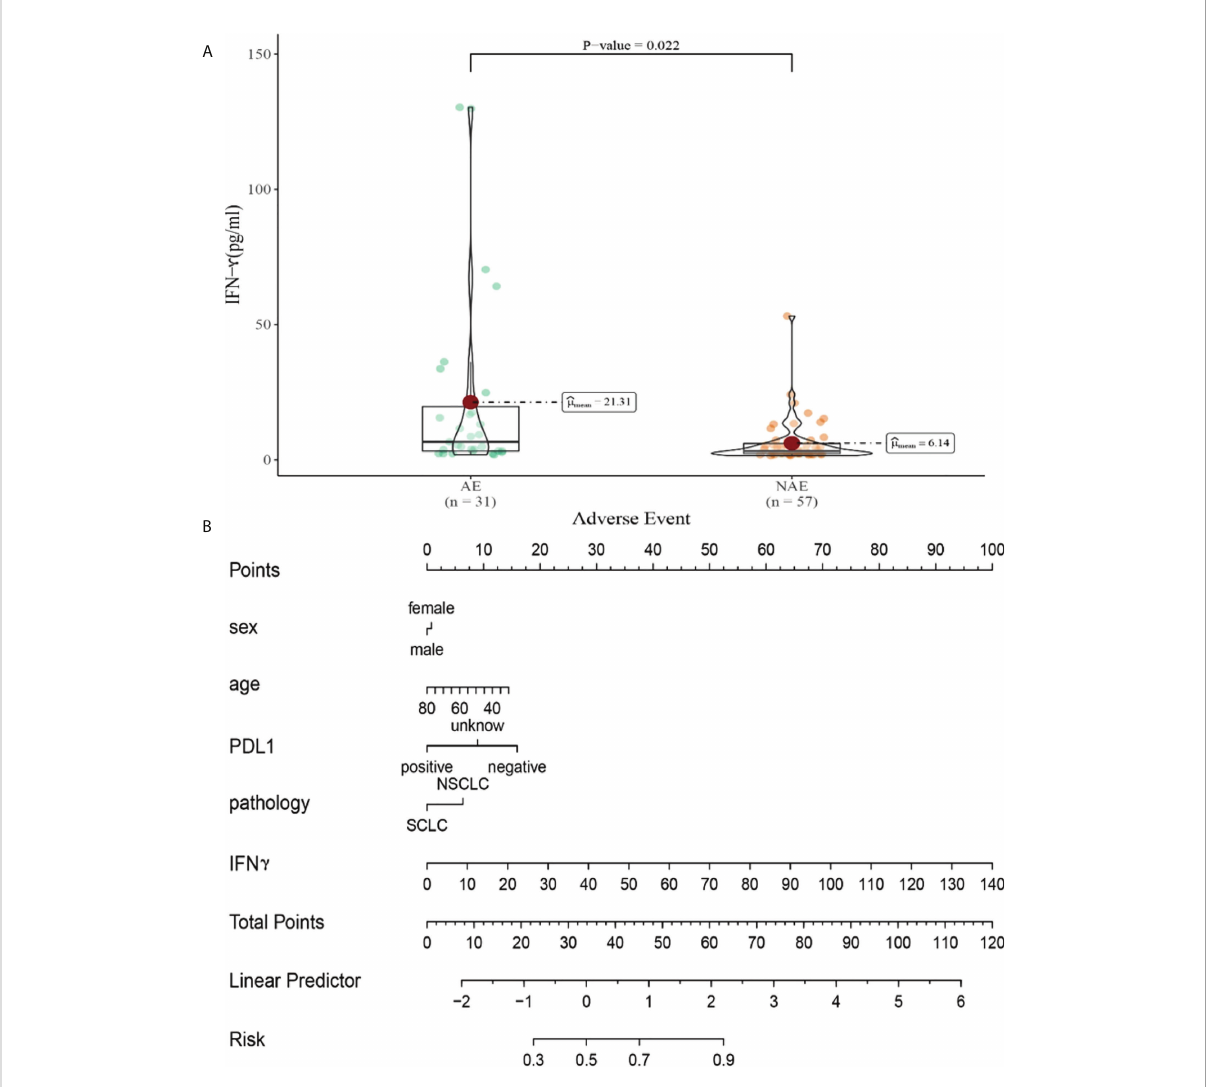
FIGURE 8 (A) Differences in IFN- g levels after the fi rst cycle therapy between AE and NAE; (B) The nomogram of irAEs prediction based on logistic multivariate